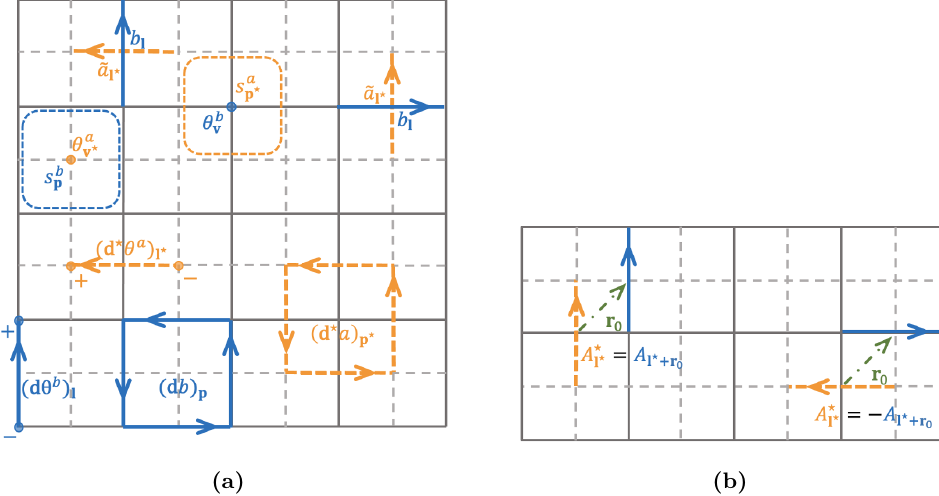
Figure 1. (a) Illustration for the lattice (solid line) and the dual lattice (dash line), the conjugate pairs of operators, and the lattice and dual lattice “exterior derivatives”. Note we have picked the natural directions of the lattice links to be +ˆ x , +ˆ y , and the natural directions of the dual lattice links to be 90 -degrees counter-clockwise to the associated lattice link directions, as labeled by the arrows. When the direction label on a link (or a dual link) reverses, the associated operator picks a negative sign. (b) A choice of identification of A ? l is chosen to locate at r 0 ≡ ˆ x / 2 + ˆ y / 2 away from l ? and η l ? = ∓ 1 for dual link l ? oriented in − ˆ x or ˆ y